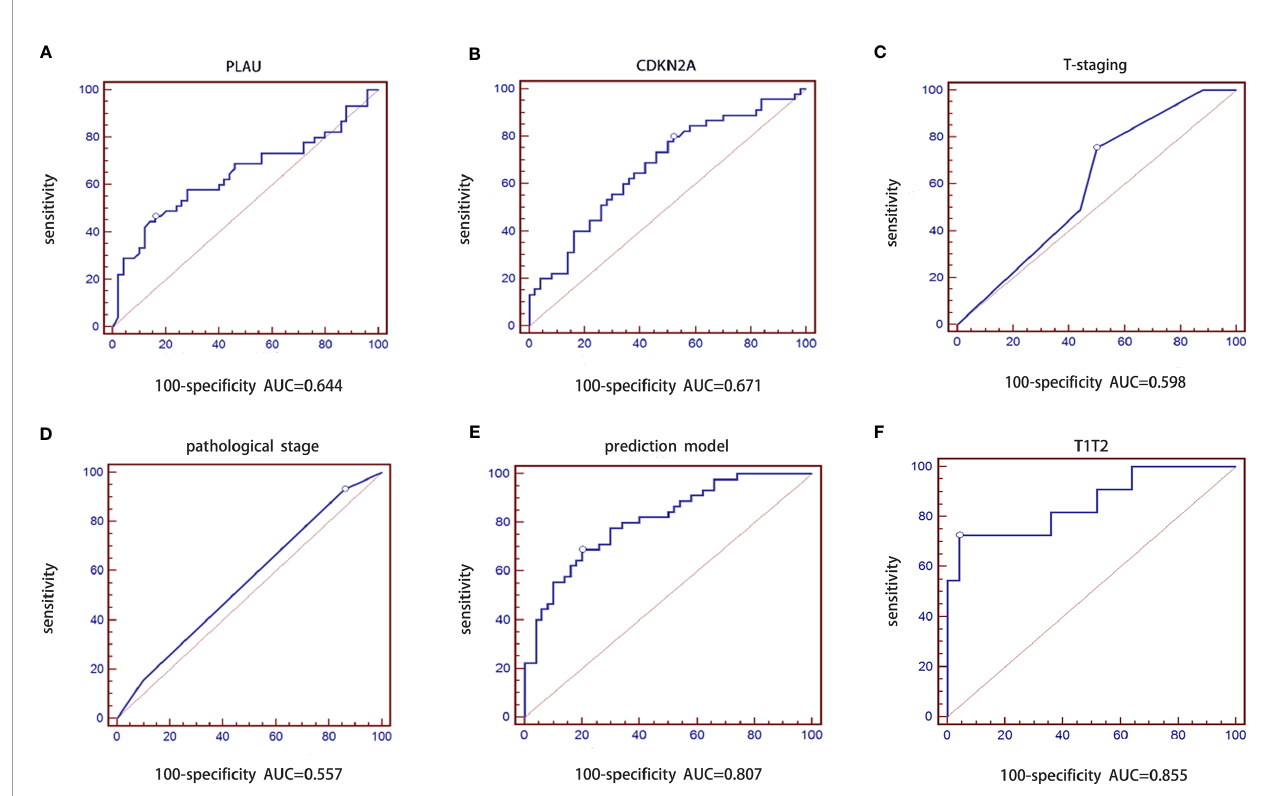
FIGURE 4 | Validation of prediction model of lymph node metastasis based on the CDKN2A and PLAU genes combined with clinicopathological parameters in the prospective group. (A) ROC curve of PLAU; (B) ROC curve of CDKN2A; (C) ROC curve of T stages; (D) ROC curve of pathological grades; (E) ROC curve of validated prediction model for the whole group; (F) ROC curve of validated prediction model for T1/T2 stage